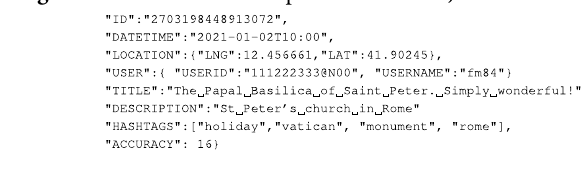
TABLE 1 | Use case application parameter de fi